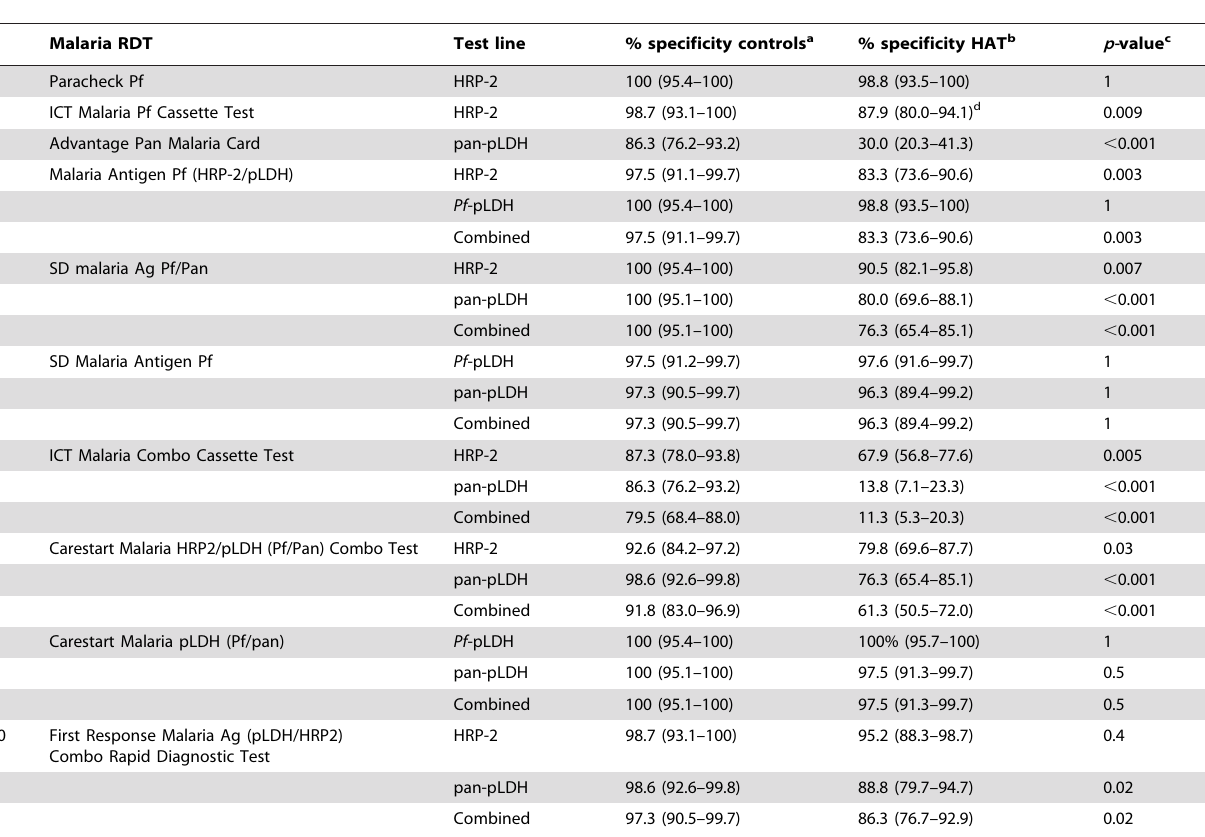
Table 2. RDT test line specificities for diagnosis of malaria infection in controls and HAT.